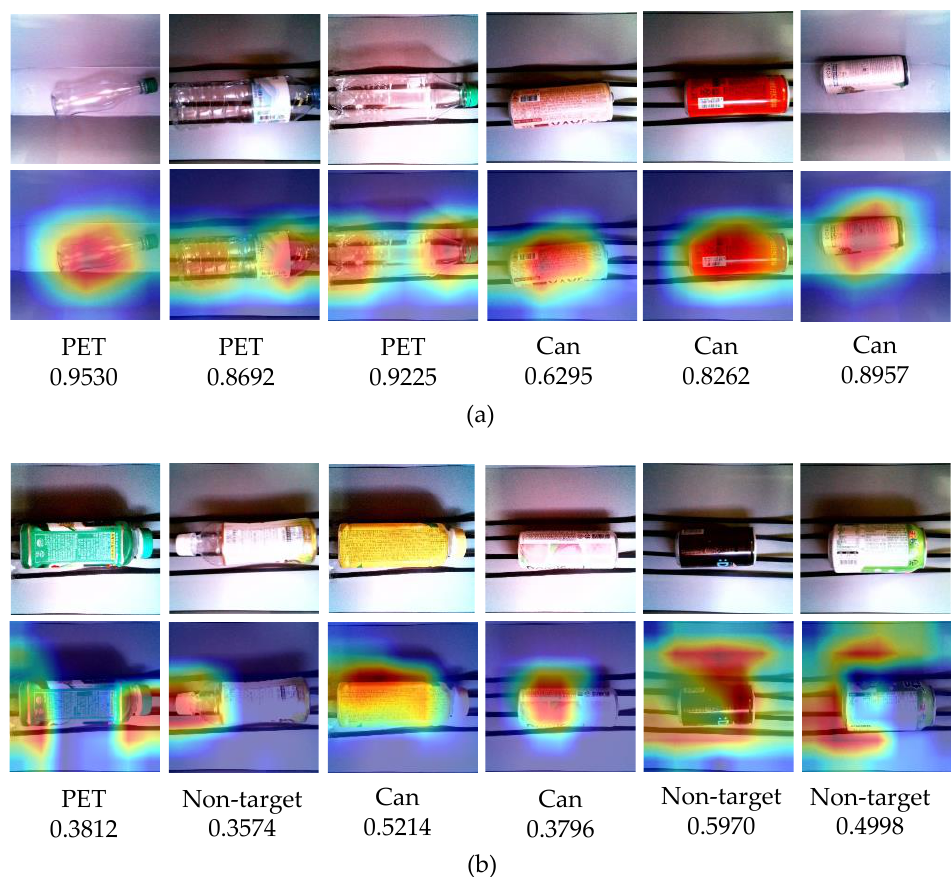
Figure 9. Grad-CAM visualization results using MobileNetV2 for target objects: ( a ) Properly classified objects; ( b ) Misclassified objects. The predicted class and its probability are shown below each Grad- CAM figure.